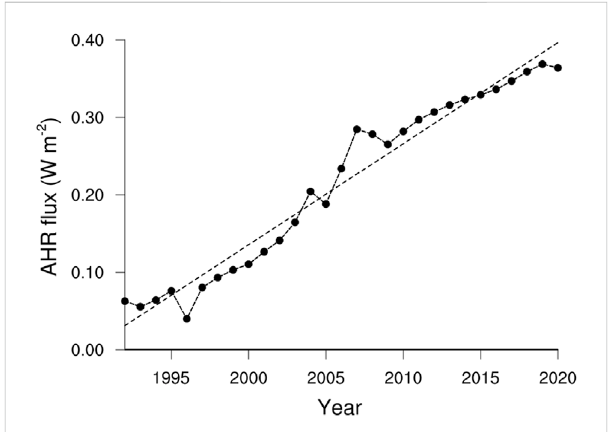
FIGURE 1 The mean fl ux of AHR in Southwest China from 1992 to 2020 with the trend fi tting line (unit: W m -2 ), and the slope value k =